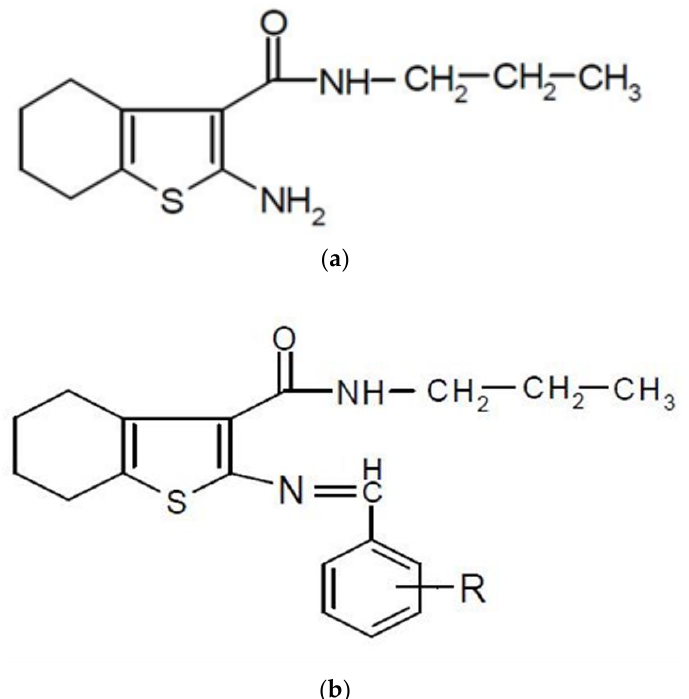
Figure 7. ( a ) 2-((substituted benzylidene) imino)-3-N-(propyl carboxamido)-4,5,6,7-tetra hydro benzo ( b ) thiophenes (Schiffs bases)(IIa-k)): TLC solvent system: Benzene: Ethyl acetate (7:3); Recrystallization solvent: DMF : Water(9:1).